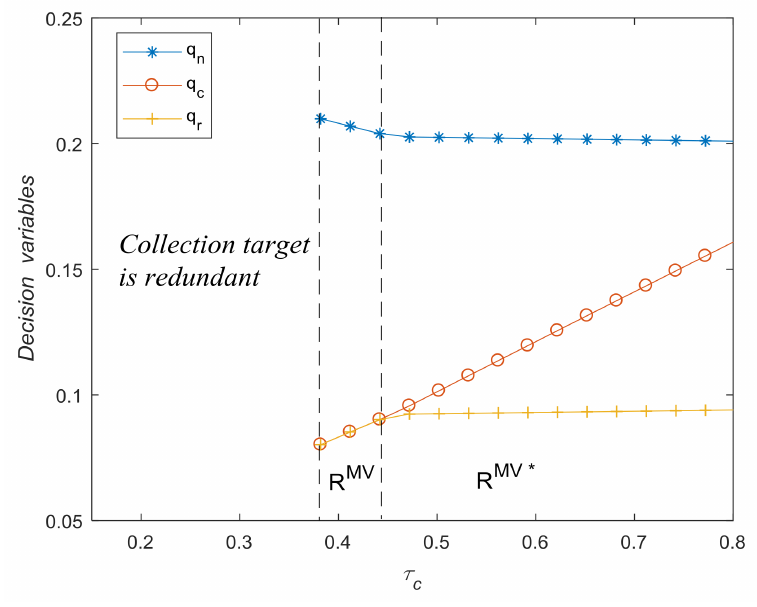
Figure 5. The impact of τ c on optimal decisions.